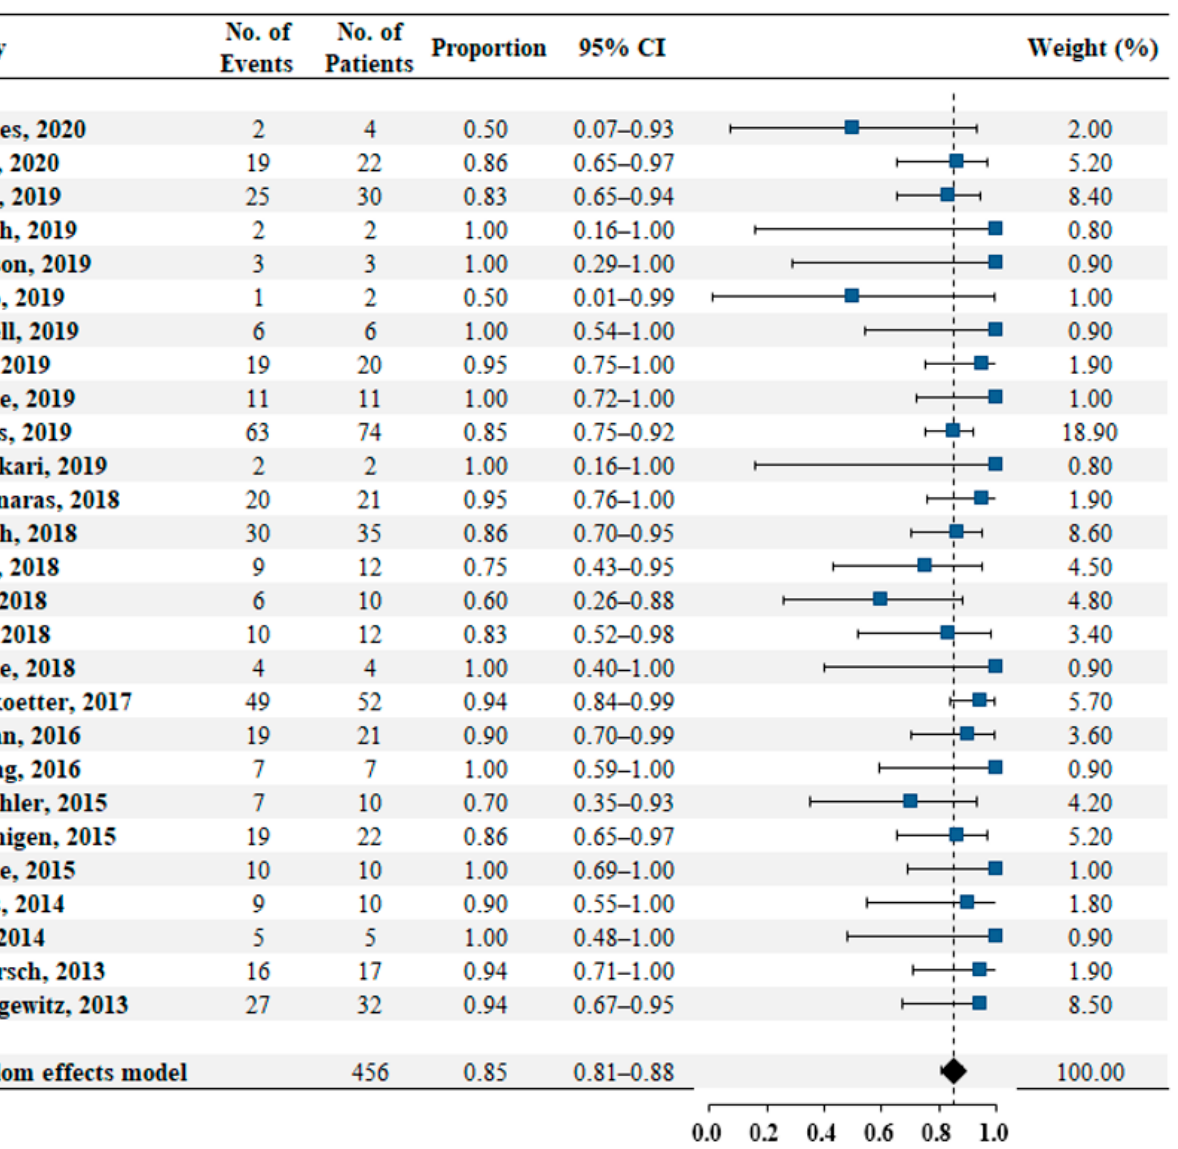
Figure 2. Pooled estimate rate for successful closure in patients with transmural defects of upper gastrointestinal tract.